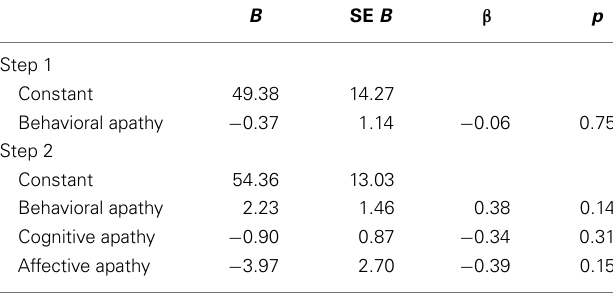
Table 7 |Apathy domains and the Iowa gambling task